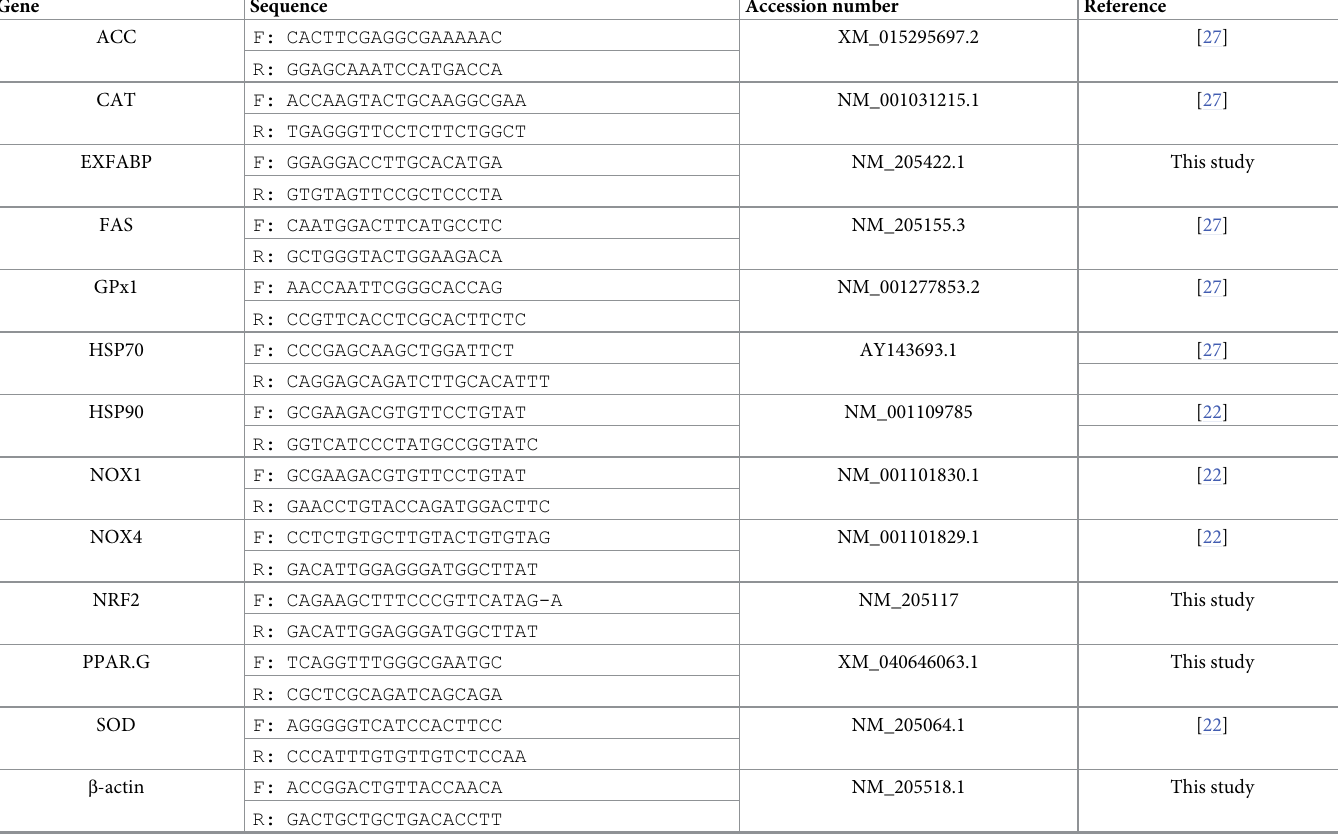
Table 1. Oligonucleotide primer sequences for